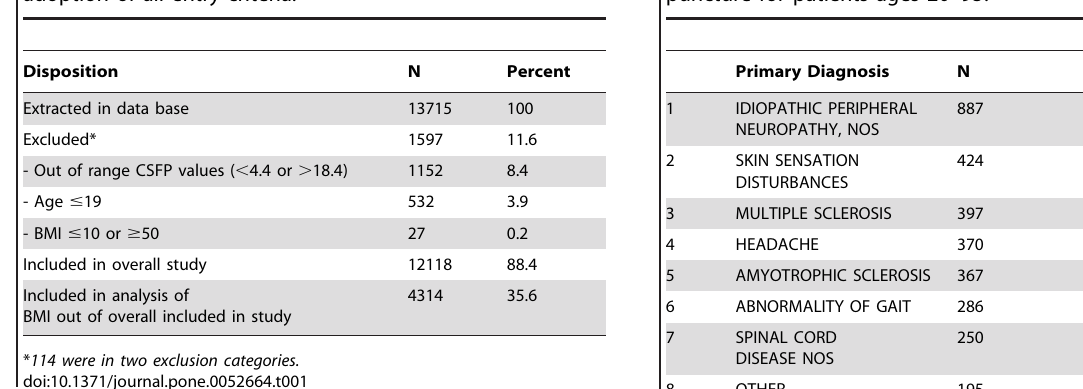
Table 1. Derivation of the final study population after adoption of all entry criteria.